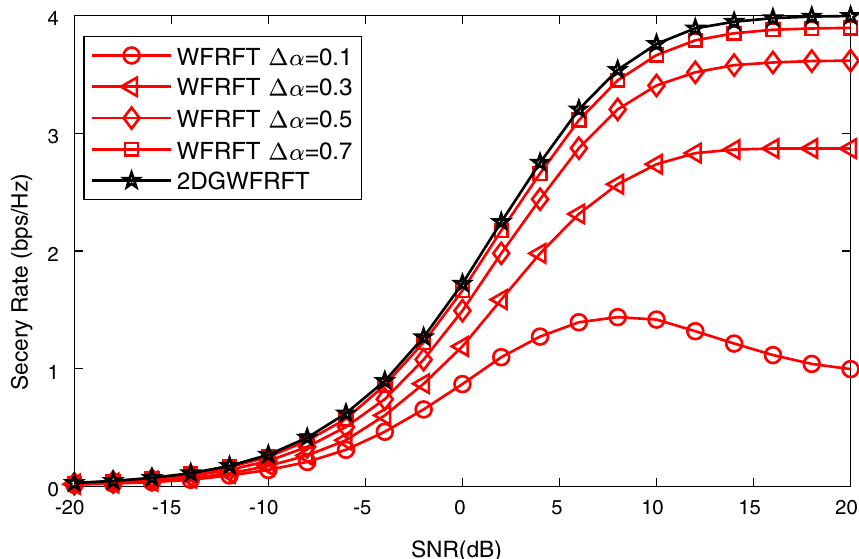
1 under different =